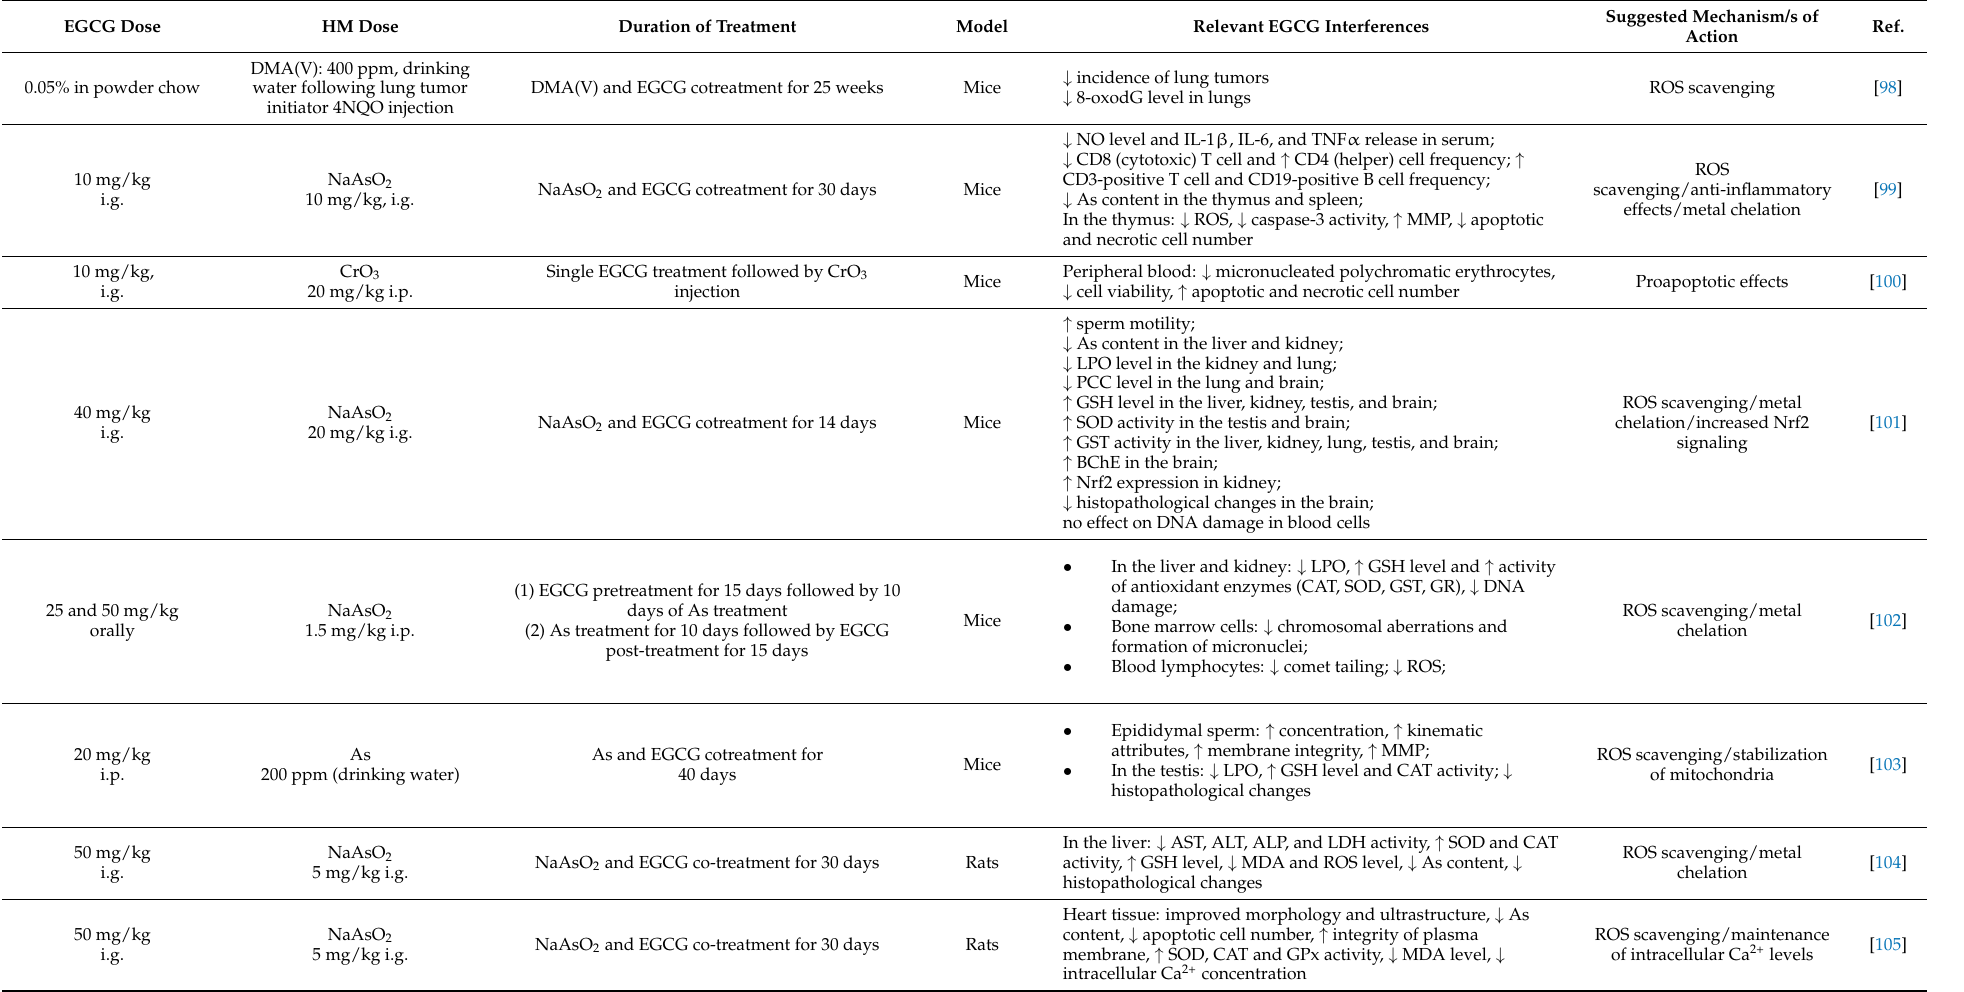
Table 2. Summary of animal studies evaluating EGCG effects on HM-induced